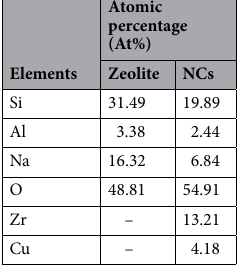
Table 4. EDX data for zeolite and